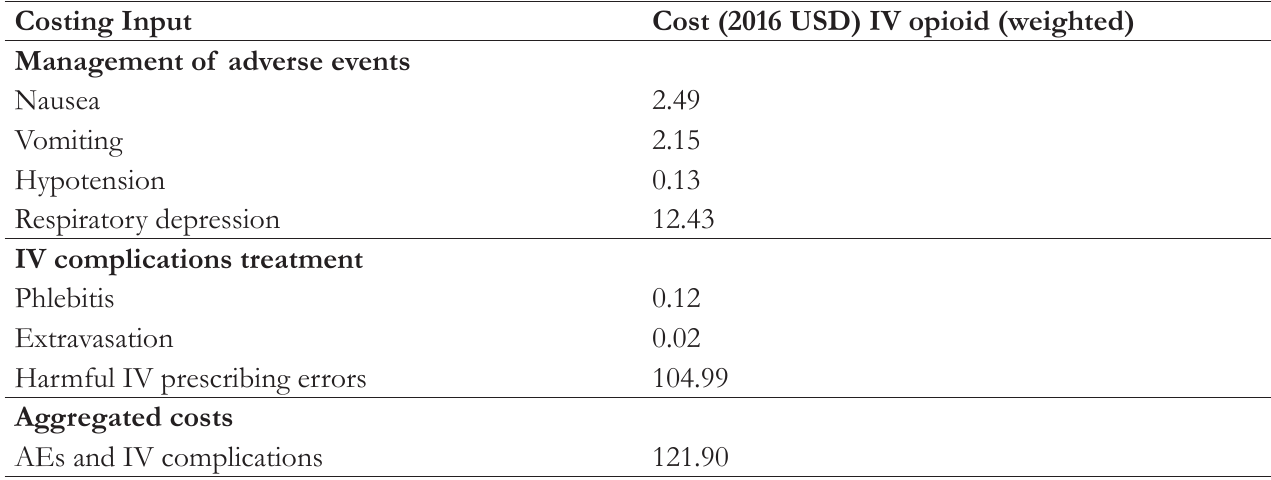
Table 8. Estimated Cost for Management of AEs and IV Complications associated with IV Opioid Use in the ED (weighted for relative frequency for morphine, hydromorphone,